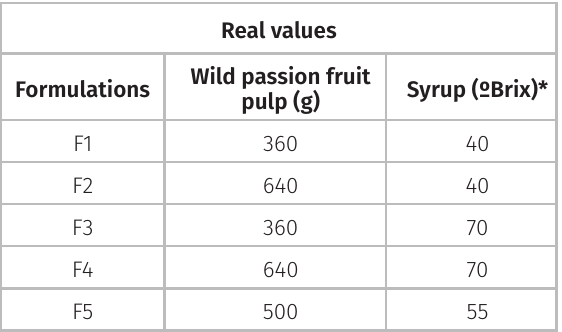
Table I. Experimental design for the processing of wild passion fruit